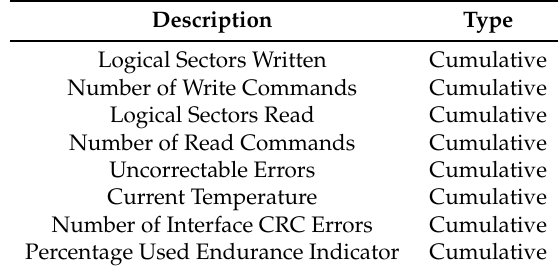
Table 5. Device Statistics.